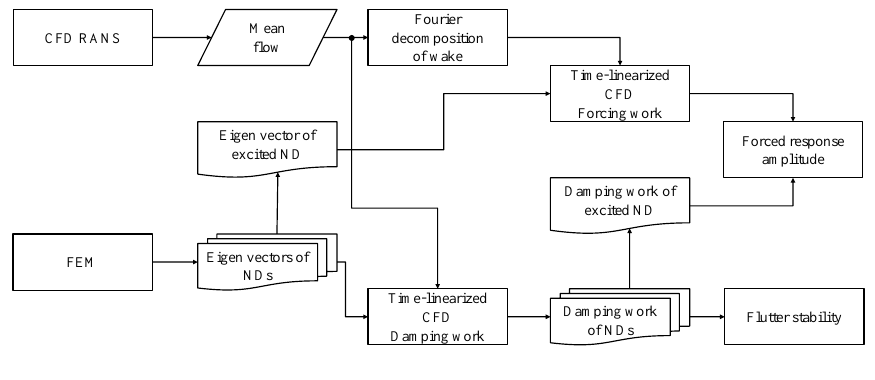
Figure 6. Forced response toolchain